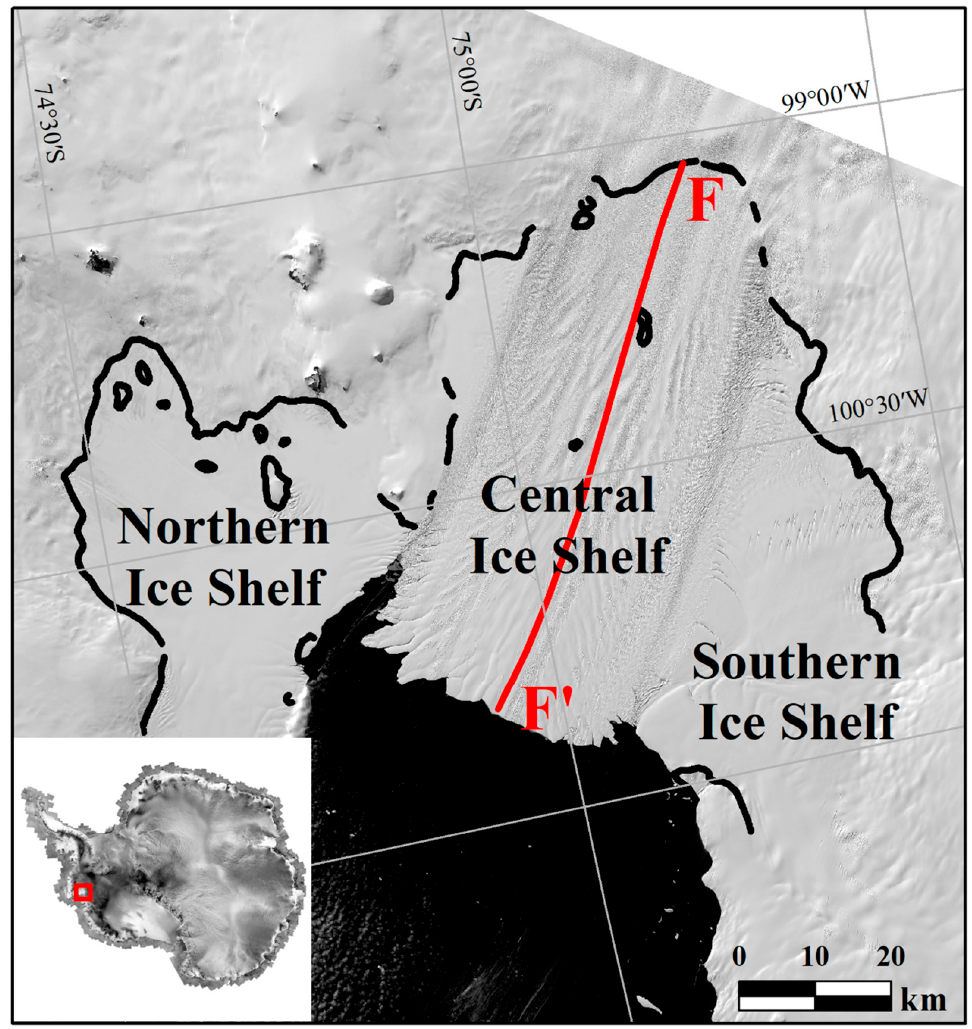
Figure 1. Landsat-8 Operational Land Imager panchromatic image of PIGIS obtained on 8 March 2015. The 2011 grounding line (2011GL) is shown as the black lines [21–23]. A longitudinal profile F-F’ along the direction of the ice flow is marked as a red line. The lower-left inset represents the study area in Antarctica.